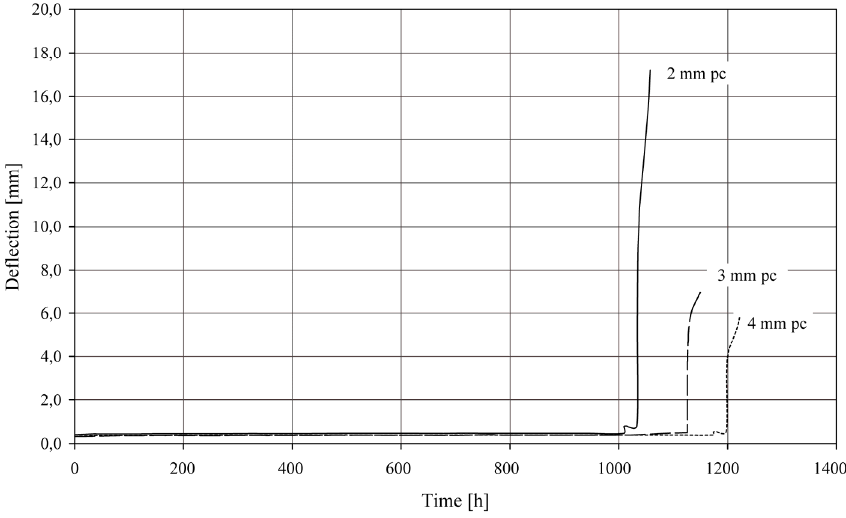
Figure 9: Deformations of composite beams with 2, 3 and 4 mm polycarbonate under constant load. With the fraction of the first glass pane the deformations increase only slightly, with the breakage of the second, they increase